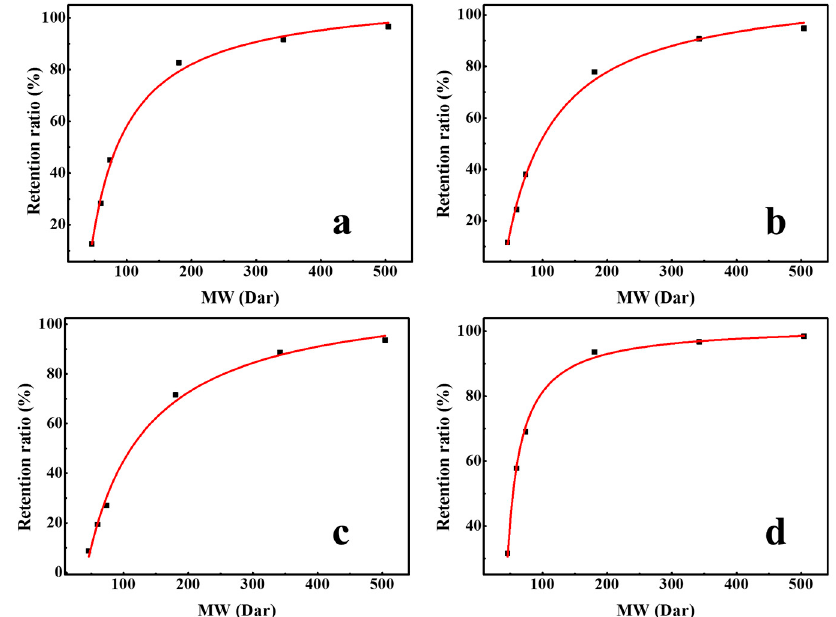
Figure 7. Retention ratio of different neutral molecules with different molecular weights (MWs) by four NF membranes ( a ) DK; ( b ) DL; ( c ) NF270; ( d ) Duracid NF.